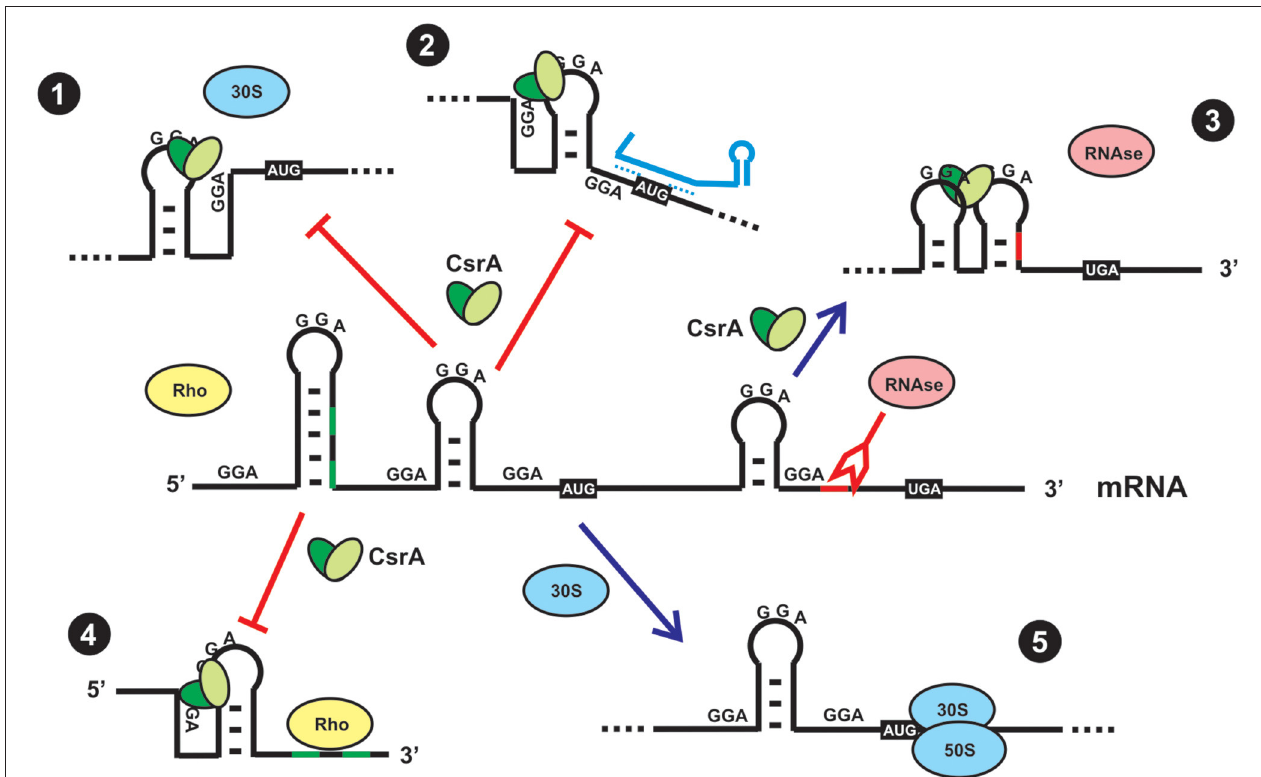
FIGURE 3 | Direct and indirect regulatory effects of CsrA binding to a mRNA. (1) Direct translational repression. In most cases, CsrA binds to target sites around or within the Shine-Dalgarno region, and as a consequence it outcompetes binding of the small ribosomal subunit and its engagement in translation initiation. (2) Indirect translational repression. CsrA binds to target sites in the 5 ′ -UTR and induces a conformational change that exposes the Shine-Dalgarno region to base-pairing by a small regulatory RNA, thus impeding access of the ribosome. (3) Indirect control of mRNA stability. CsrA binds to a target site that upon refolding, impedes access of a ribonuclease. (4) Indirect control of transcriptional termination. CsrA binds to a target site in the mRNA and induces a conformational change that exposes Rho-utilization sequences that can now be exploited by Rho protein to stop transcription elongation of the mRNA. (5) In the absence of CsrA (either due to a mutation that abolishes its function or due to sequestration by CsrA-antagonists, as depicted in Figure 4 ), a ribosome can recognize the Shine-Dalgarno sequence and initiate mRNA translation. Usually, translationally active mRNAs are protected from the action of